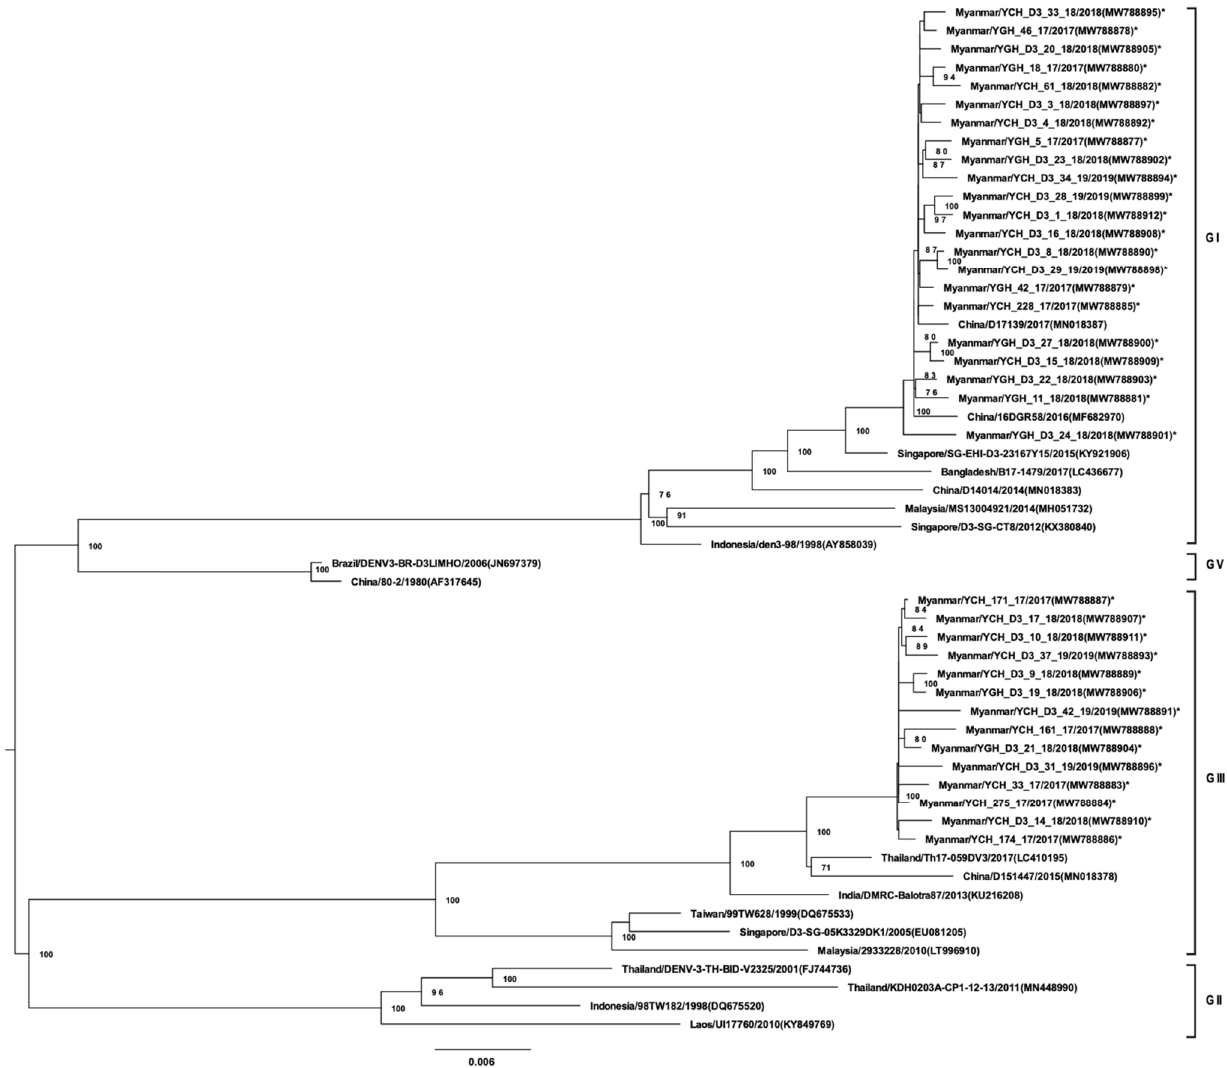
Figure 3. Phylogenetic tree of DENV-3 based on whole-genome sequencing. The maximum likelihood tree was generated using a general time reversible (GTR + I + G) model with 1000 bootstrap replicates. Bootstrap values of >70 were indicated in the nodes. The tree shows global DENV strains, and the 36 DENV-3 isolates from this study are indicated by asterisks. Representative strains of each genotype were named by country of origin, strain name, year of isolation, and accession number (GenBank).